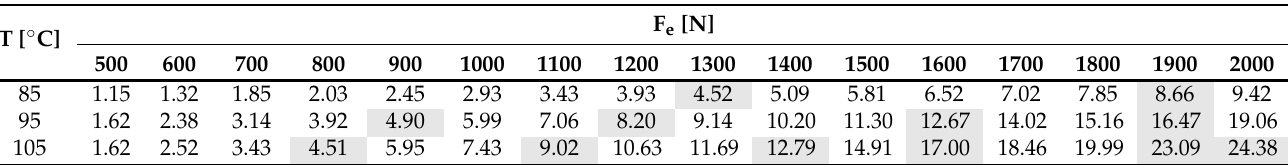
Table 3. Calculated printing speeds (v c ) as a function of F e and T; v c values that satisfy Equation (6) are highlighted in